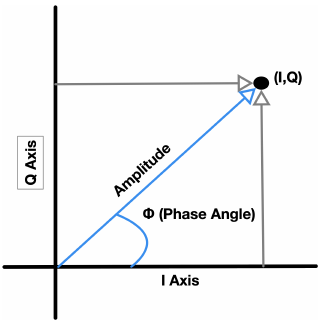
Figure 10. In radiogoniometry applications, the receiving BLE device takes IQ samples of phase angle and amplitude throughout the CTE part of a BLE package for every array’s antenna. Then, this information can be reproduced as cartesian coordinates (I, Q).